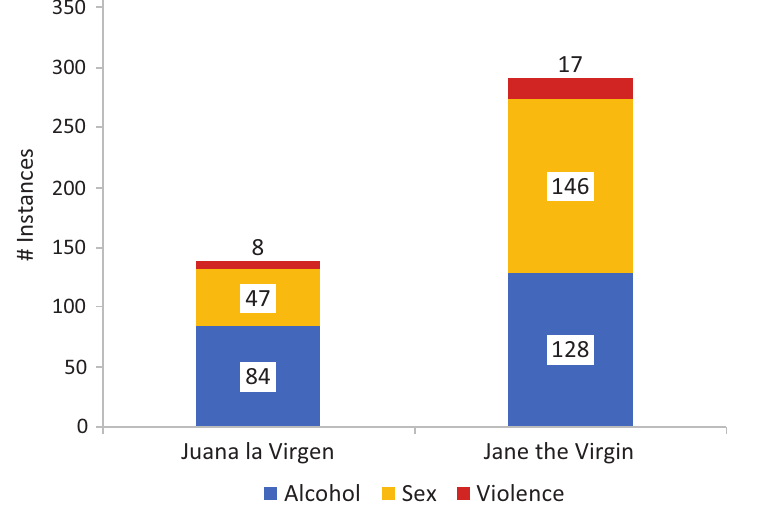
Figure 1. Risk variable instances summed per TV